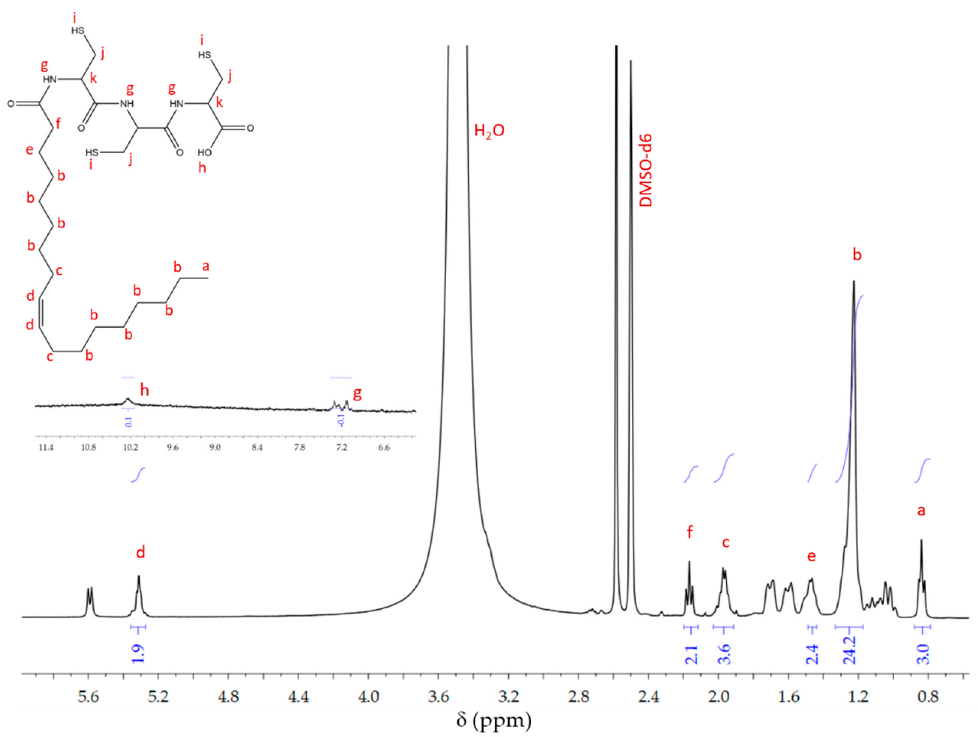
Figure 3. 1 H-NMR spectrum of (MAT).